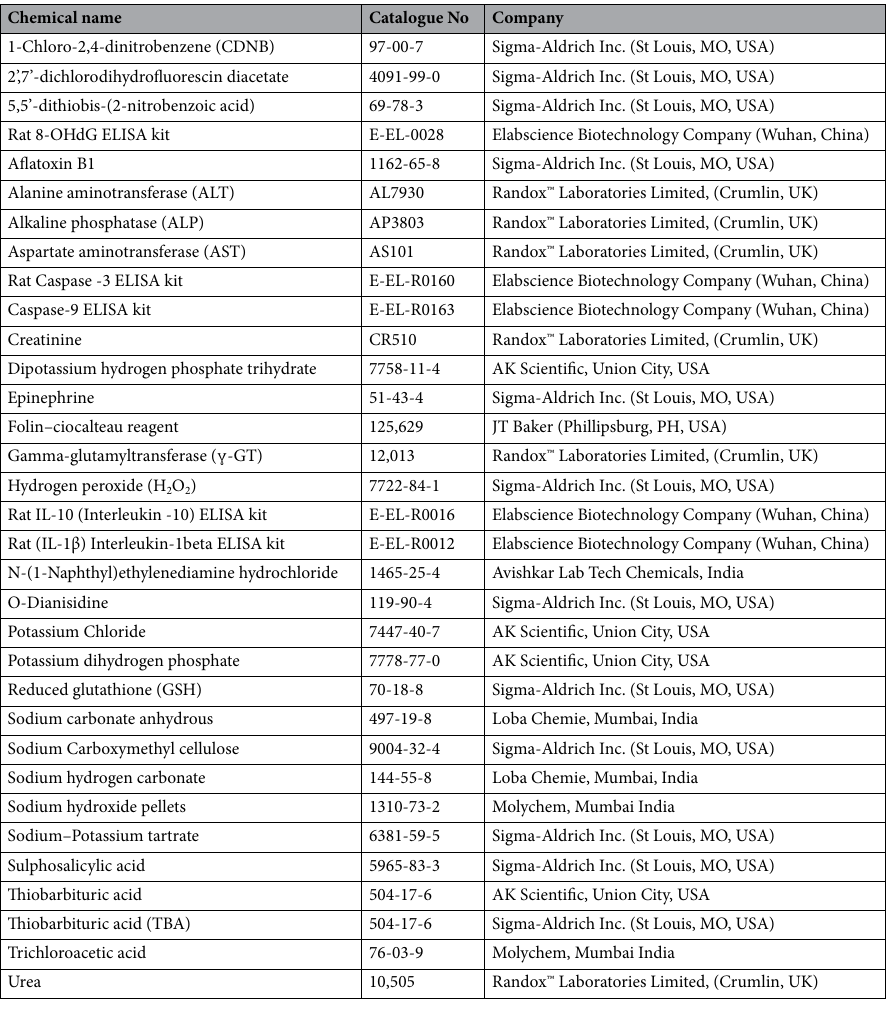
Table 1. List of chemicals, reagents and kits used for the estimation of the oxidative, inflammatory, and apoptotic biomarkers in the liver and kidney of